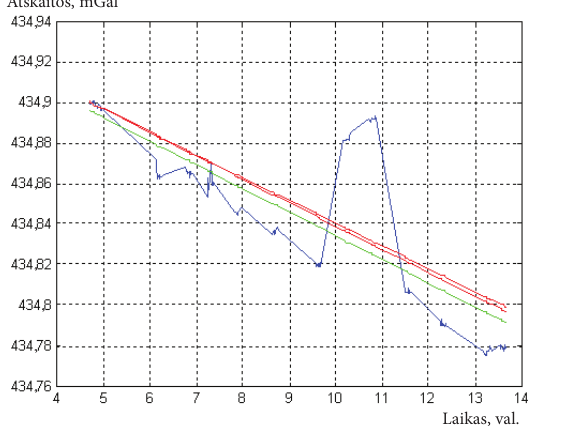
2 pav . Redukuotųjų atskaitų skirtumai (G3-G4, 2007-11-20) Fig. 2 . Differences in the reduced readings (G3-G4, 20.11.2007) Table 2 . Readings of the gravimeter G2 at the point PANEVĖŽYS Šie grafikai teikė papildomos informacijos apie gra- vimetrų veikimo kokybę reiso metu. Iš netiesinio redu- Laikas Atskaita val. min. sek.